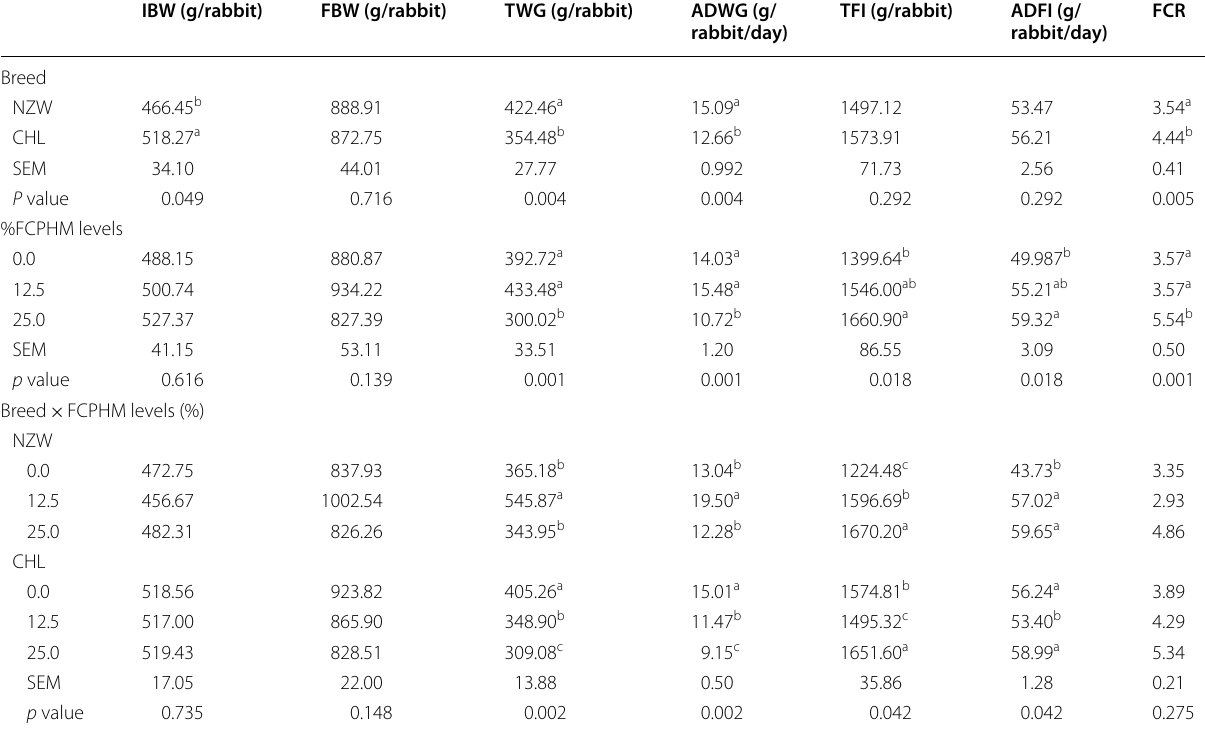
Table 2 Growth performance of New Zealand White and Chinchilla rabbits fed varied levels of FCPHM from 1st to 4th